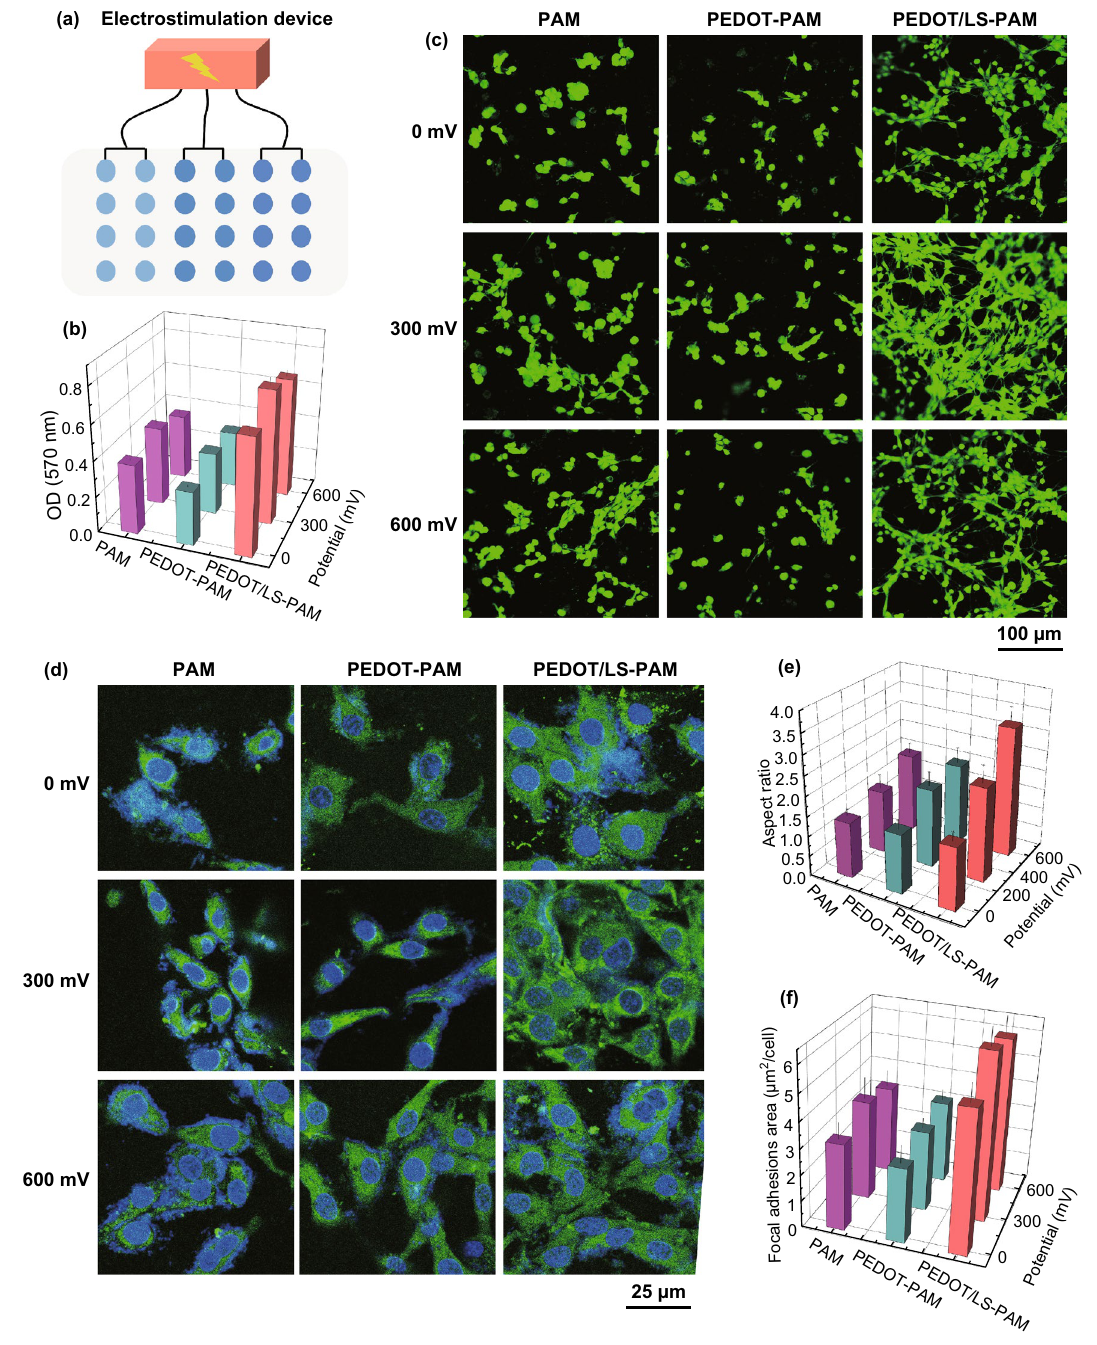
Fig. 8 Electrostimulation of C2C12 cells on different hydrogels after 7 days of culture. a Homemade multi-channel high-throughput cell elec- trical stimulation device. b Proliferation of C2C12 measured by MTT analysis. c Fluorescent micrographs of C2C12 cultured on different hydrogels under electrostimulation. Cells were stained by Calcein-AM (Green). d Focal adhesion formation of C2C12 cells on different hydro- gels under electrostimulation. Cell stained with DAPI for nuclei (blue) and monoclonal antibody for focal adhesions (green). e Aspect ratio of C2C12. f Focal adhesion size per